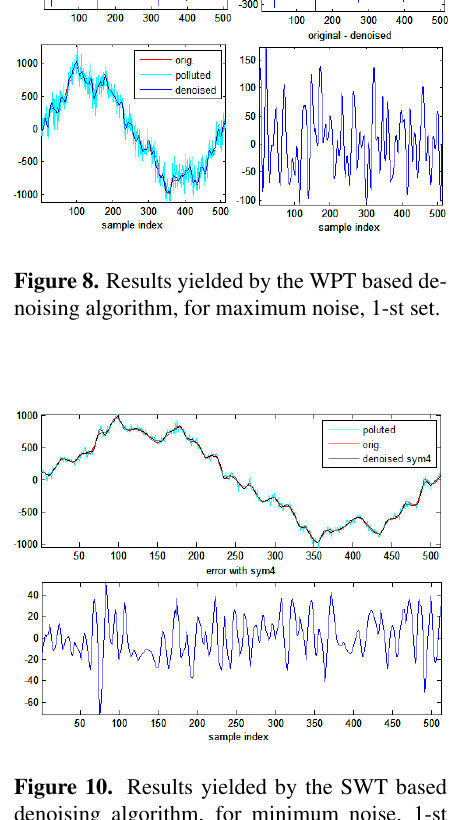
Figure 10. Results yielded by the SWT based denoising algorithm, for minimum noise, 1-st